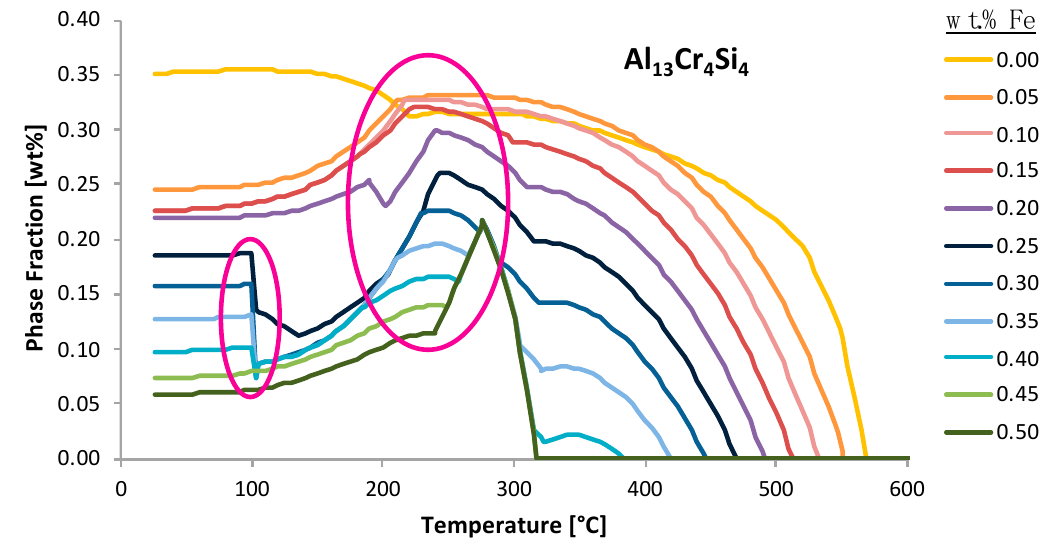
Figure 26. The phase fraction of Al 13 Cr 4 Si 4 as a function of temperature and iron content for demonstrative purposes.